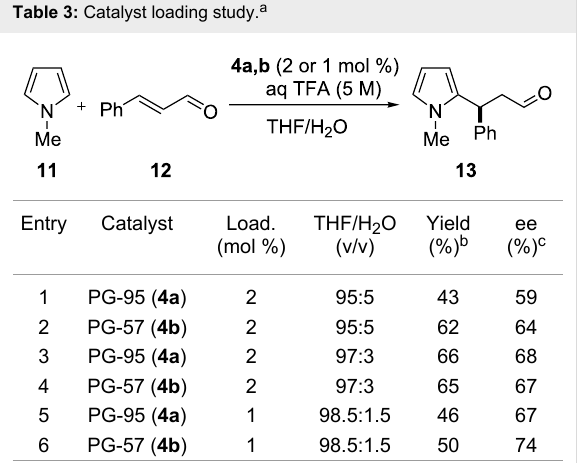
Table 3: Catalyst loading study. a